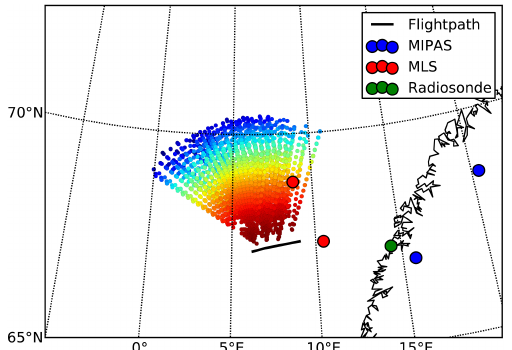
Figure 5. Simulated GLORIA dynamics-mode spectra for 16km tangent altitude applying the MIPAS reference atmosphere for mid- latitudes. The spectral windows utilized in the retrieval are marked by blue vertical